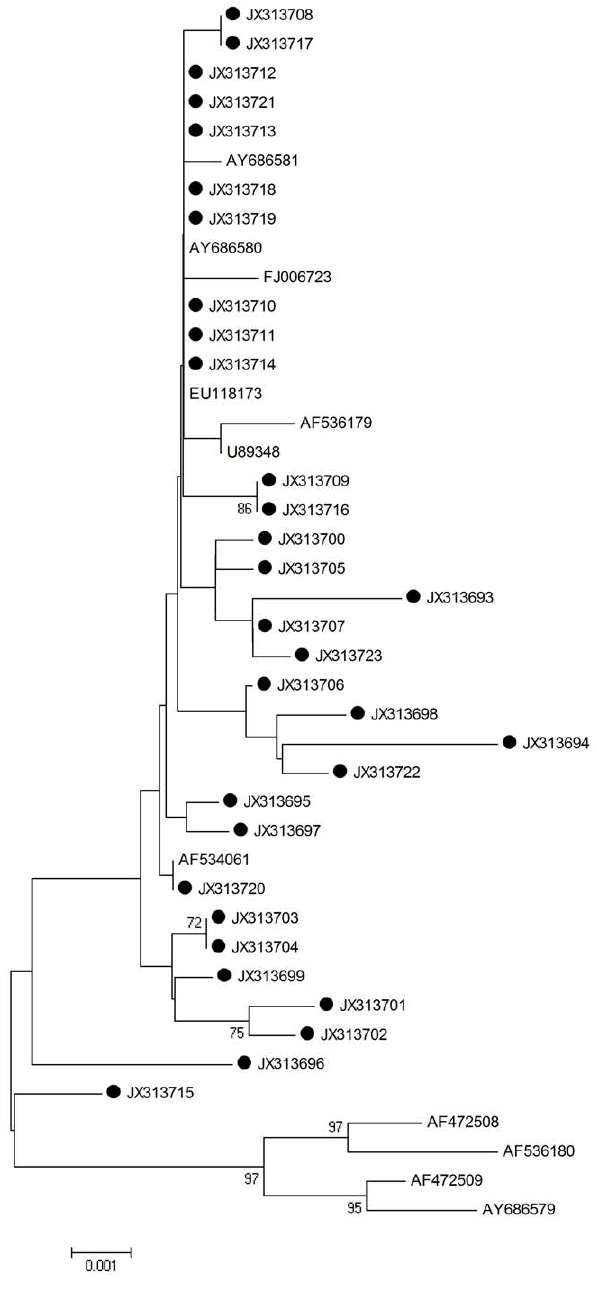
Figure 1. Neighbor joining phylogenetic tree generated using the nucleotide sequences of HPV-16 L1 gene. Study sequences are labeled in black. Others are standard sequences, including: AY686580, FJ006723 (China, Xinjiang), AY686581, EU118173, AF534061, U89348, AF536179, AF472508, AF536180, AF472509, and AY686579. Phylogenetic trees were constructed by the Neighbor- Joining method and the Kimura 2-Parameter model by MEGA package.